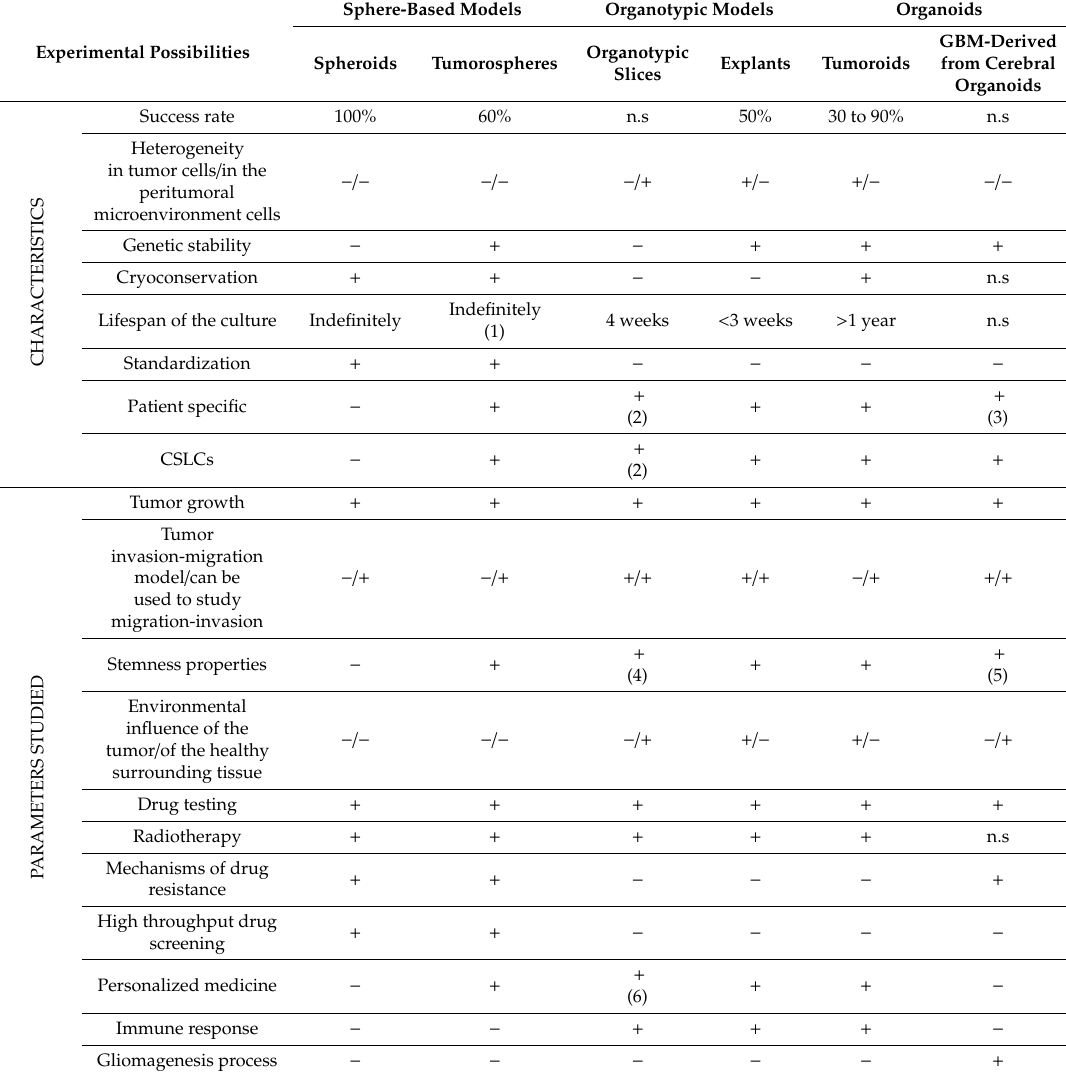
Table 3. Experimental possibilities o ff ered by each 3D